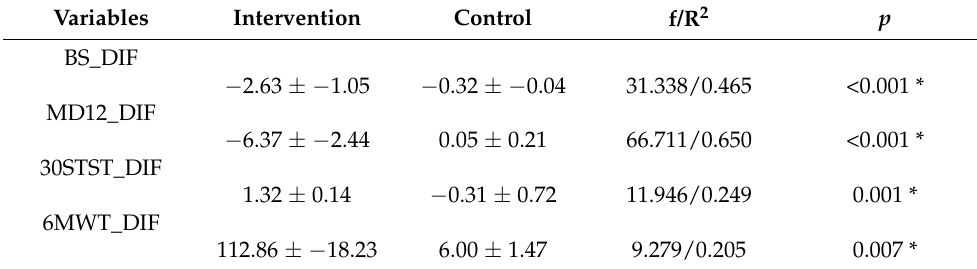
Table 3. Between-group